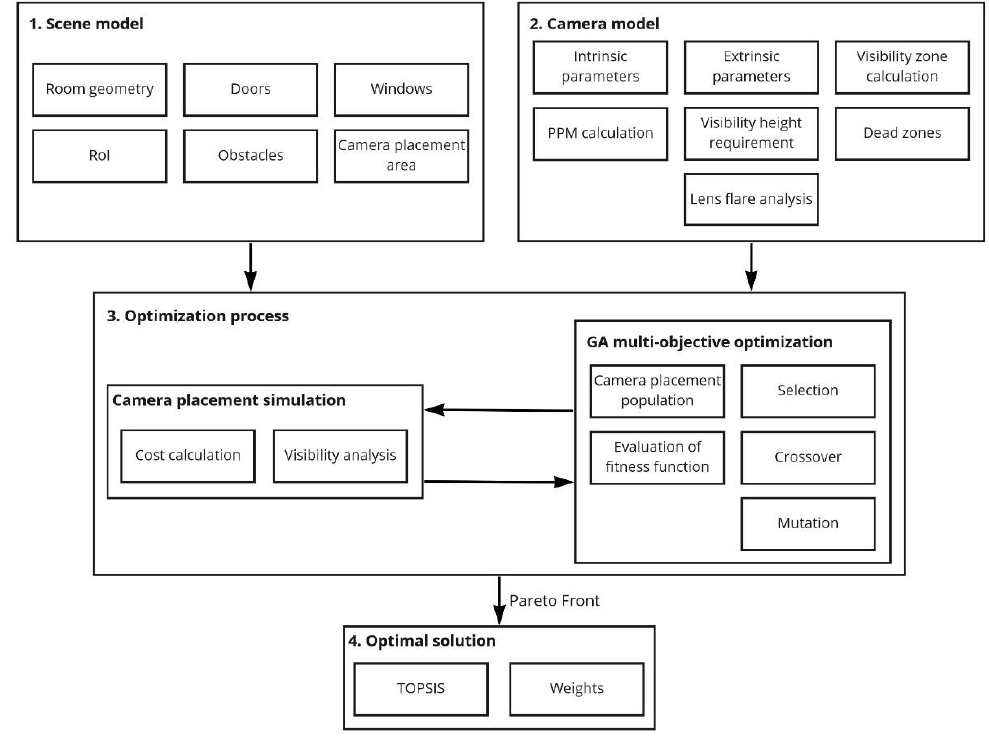
Figure 1. Proposed method of automatic placement of visual sensors.